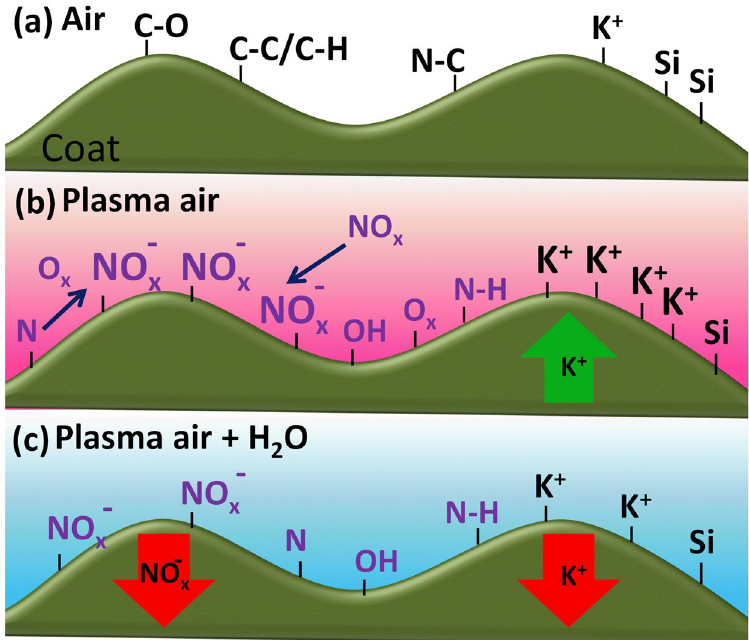
Figure 6. Schematic diagram of the chemistry of the seed surface of original seeds ( a ), after treatment with DBD air plasmas ( b ) and posterior exposure to water